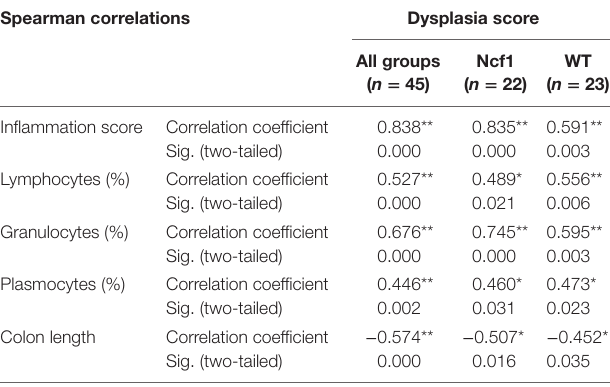
TaBle 1 | Spearman correlations and p -values for dysplasia score vs inflammation score, frequency of leukocytes infiltrating the colon mucosa and colon